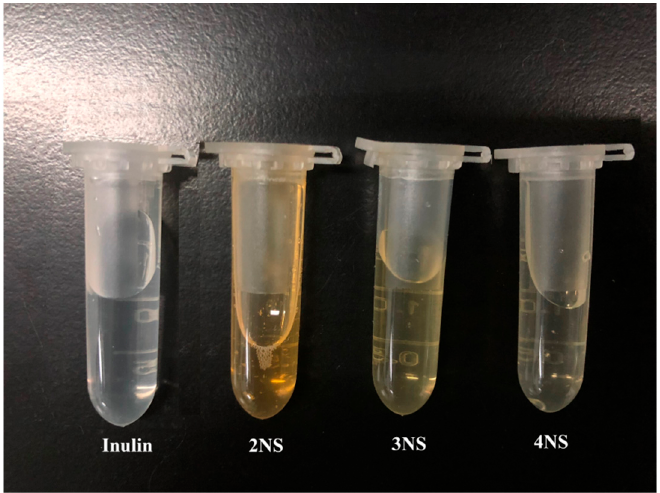
Figure 4. Solution of the synthesized Schiff bases of inulin (neutral water, 2.0 mg/mL) and inulin (neutral water, 2.0 mg/mL).